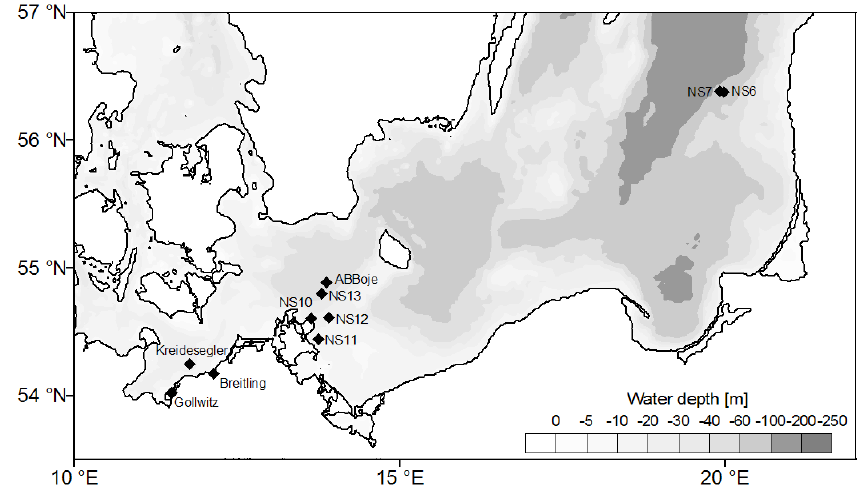
Figure 1: Map showing the stations in the western and central Baltic Sea. Fig. 1. Map showing the stations in the western and central Baltic